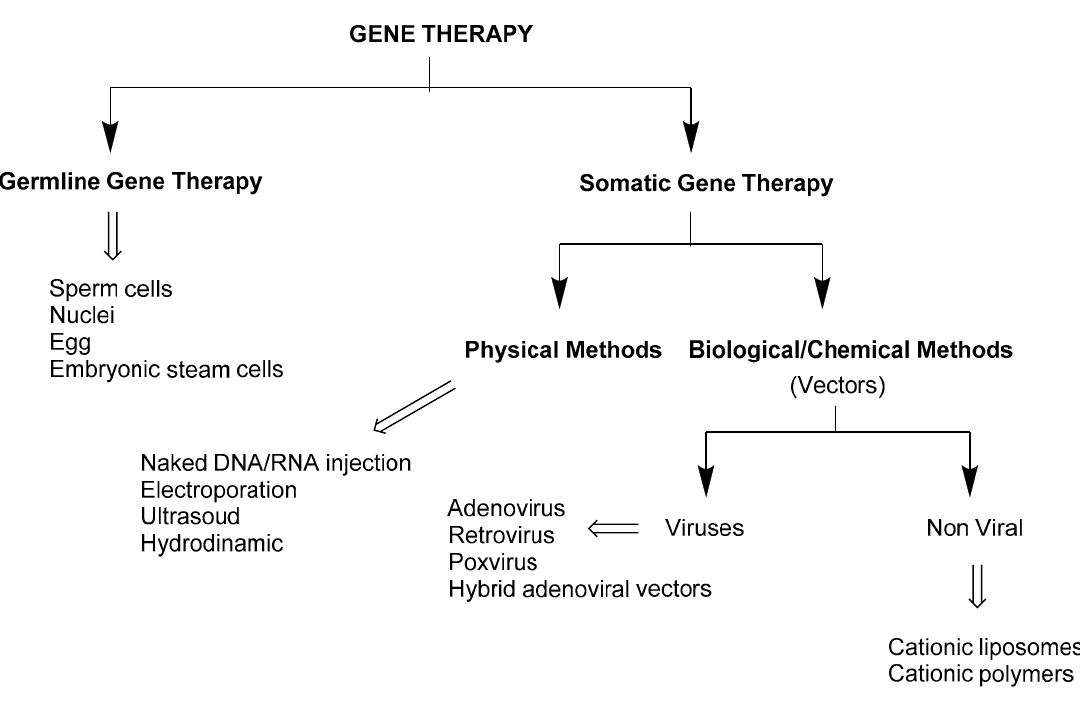
Figure 3. Different gene delivery systems. Figure 3. Di ff erent gene delivery